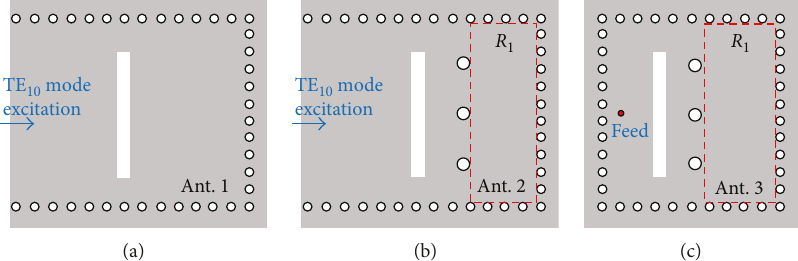
Figure 2: Design evolution. (a) SIW transverse slot. (b) SIW transverse slot with metal posts. (c) SIW cavity-backed transverse slot with metal posts.